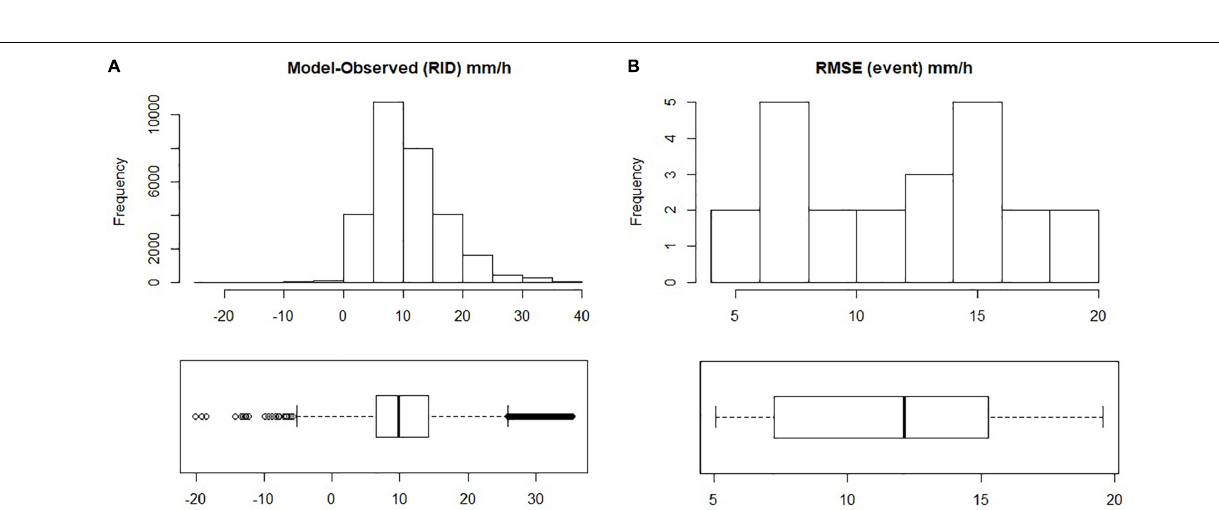
FIGURE 6 | Graphical representation of the satellite scan over the study area on April 5, 2012, from 8:50 a.m. to 8:53 a.m. The variable analyzed for this rainfall event are (A) TPW, (B) SST, (C) RID, (D) maximum rainfall modeled by the exponential model, and (E) difference between the modeled and observed rainfall.